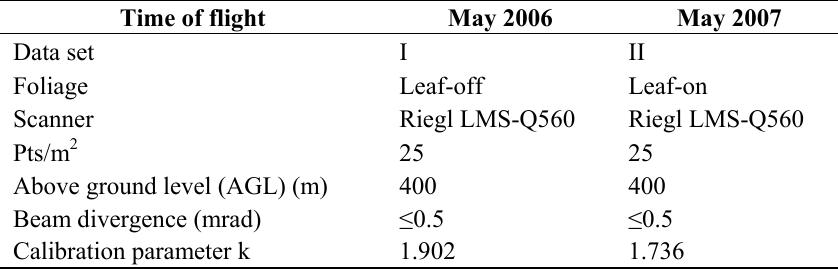
Table 2. Configurations for airborne light detection and ranging (LiDAR) campaigns for Test Site I.